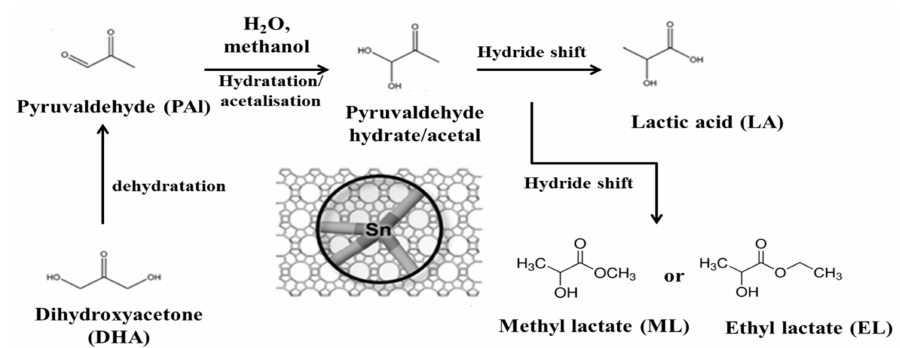
Figure 6. Scheme of triose isomerization reaction to lactic acid (LA) or alkyl lactates—methyl lactate (ML) or ethyl lactate (EL)